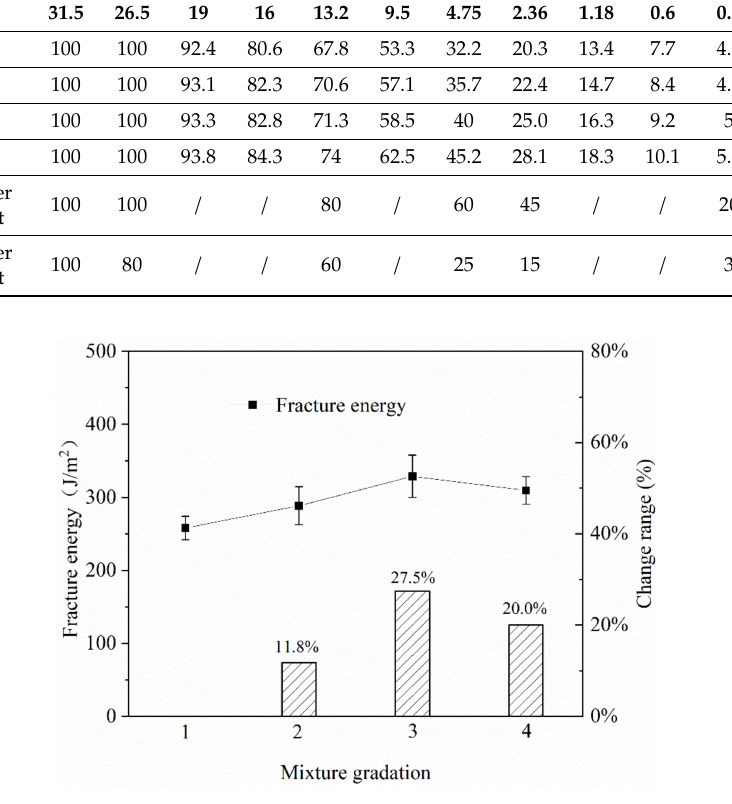
Figure 10. The e ff ect of gradation on fracture